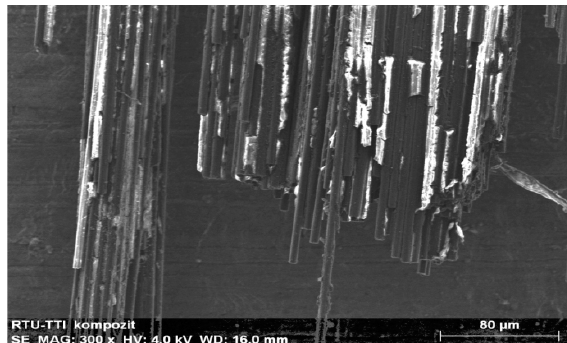
Fig. 12. Photo of the destroyed sample fragment